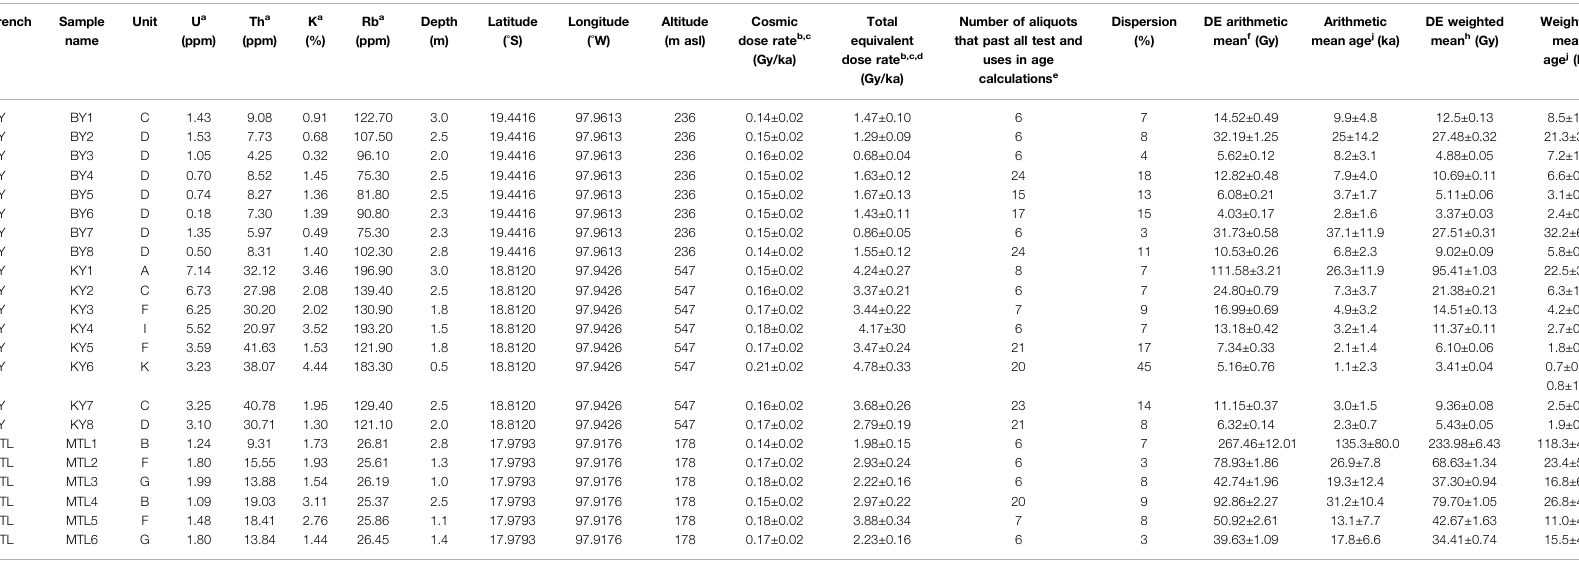
TABLE2| OSLdatingresultsofextractedsedimentsfromthestudyarea,MaeHonSonProvince,northernThailand,containingradioisotopeconcentrations,moisturecontenttotaldoserate,equivalentdoseestimates,and absolute ages.